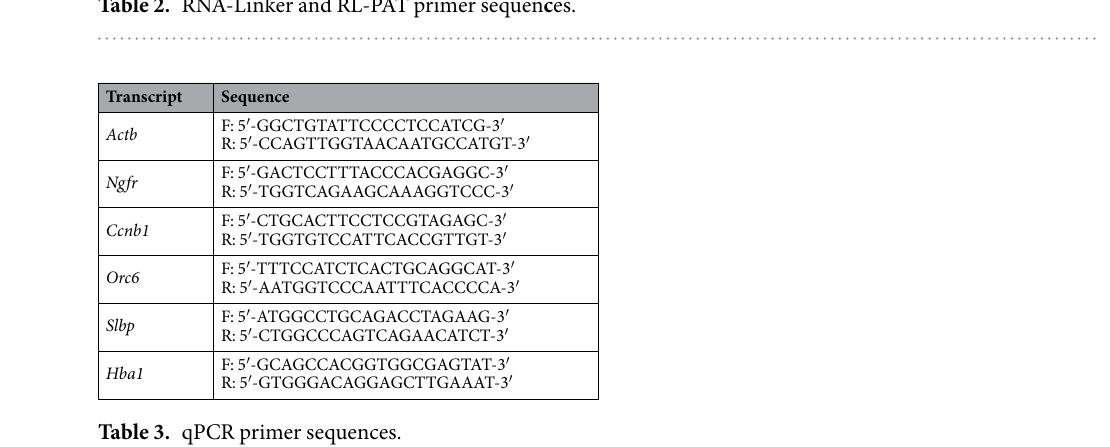
Table 2. RNA-Linker and RL-PAT primer sequen c